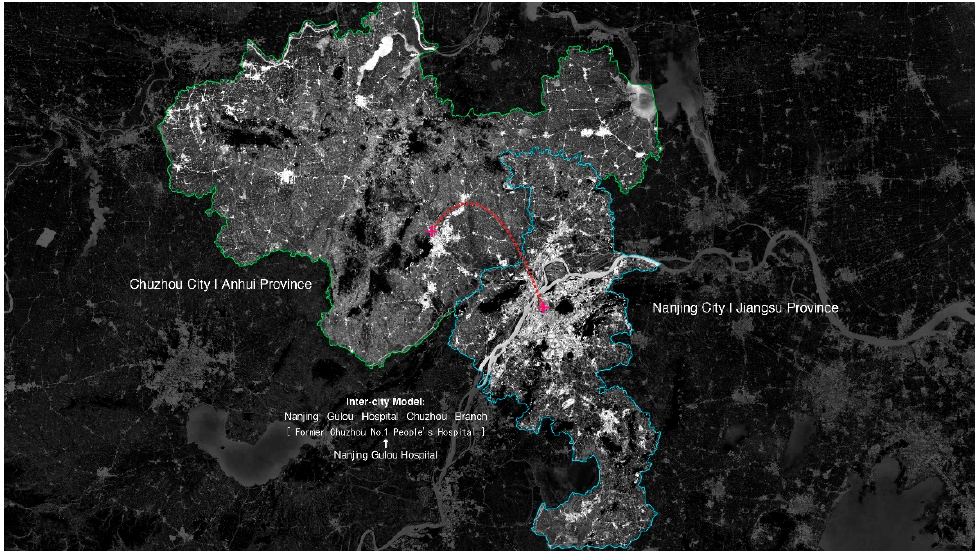
Figure 2. The Nanjing-Chuzhou inter-city’s (province) IDS.